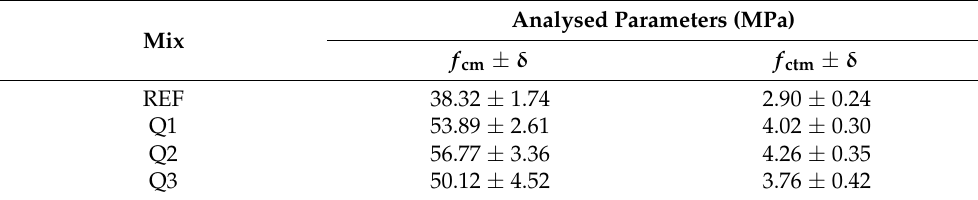
Table 7. Compressive strength and splitting tensile strength of quaternary